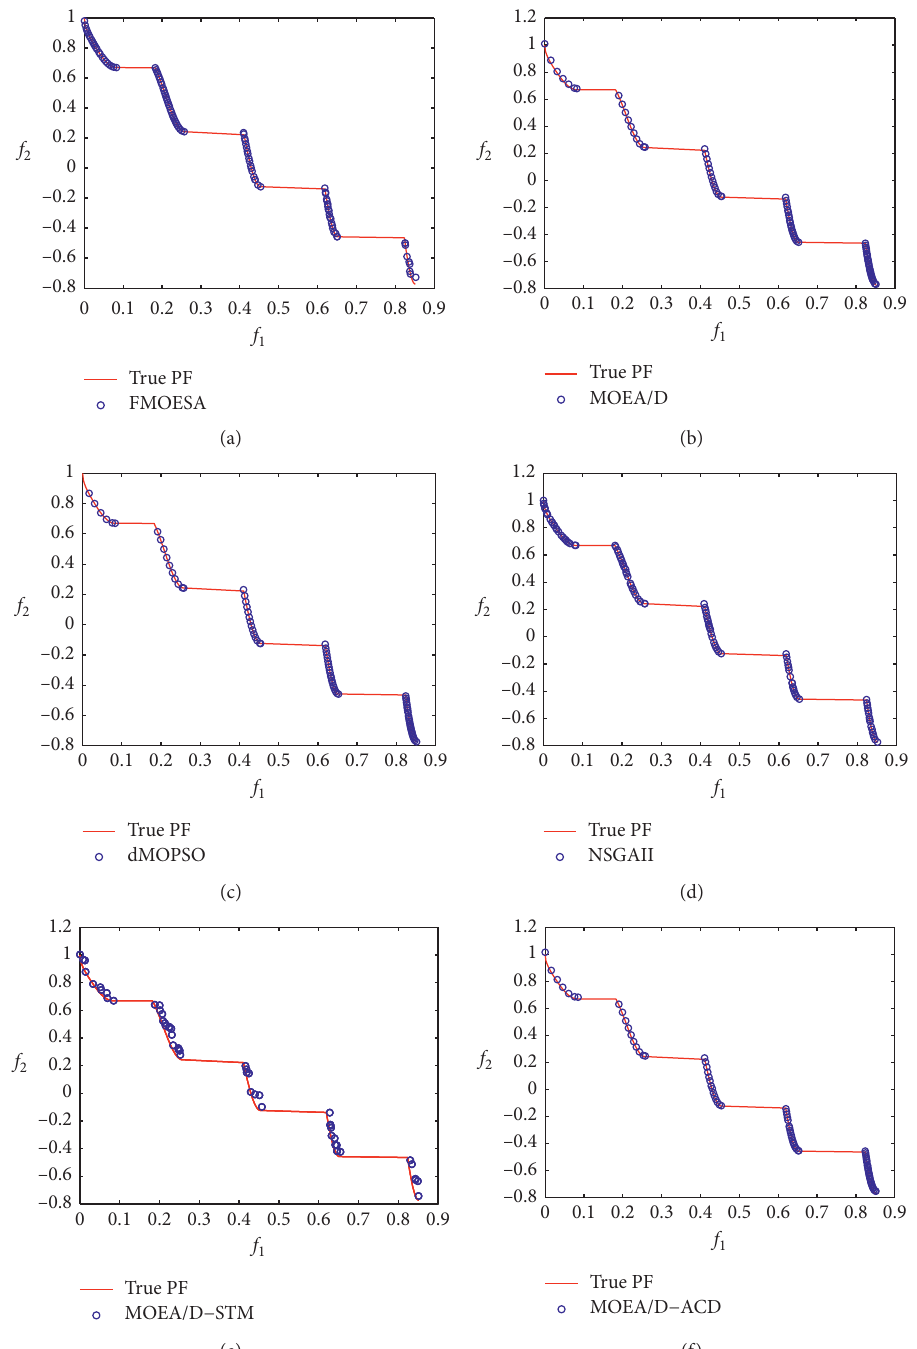
Figure 2: The approximate front of FMOESA, MOEA/D, dMOPSO, NSGAII, MOEA/D-STM, and MOEA/D-ACD on ZDT3. (a) FMOESA, (b) MOEA/D, (c) dMOPSO, (d) NSGAII, (e) MOEA/D-STM, and (f)